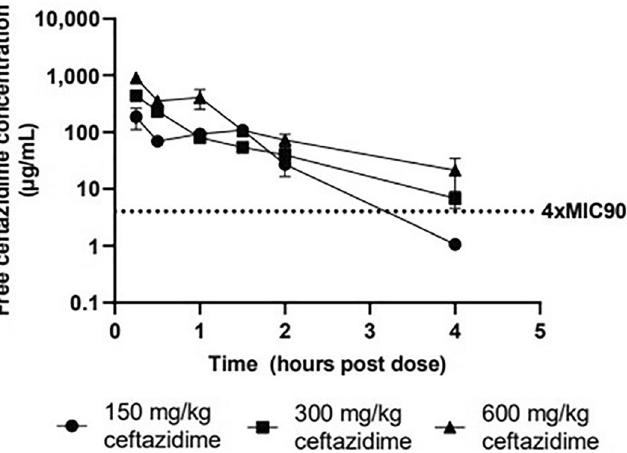
Figure 4. Free concentration–time curve for ceftazidime in murine plasma. The concentration–time curve of ceftazidime in murine plasma following a single dose administered IP 24 h following exposure to a lethal dose of B. pseudomallei . Each of the three doses administered showed a monophasic decline. Terminal phase half-lives were similar for the 300 and 600 mg/kg groups, but lower for the 150 mg/kg group. C max and AUC values increased in a near dose-proportional manner for all 3 groups suggesting no dose effects on the systemic exposure of ceftazidime.